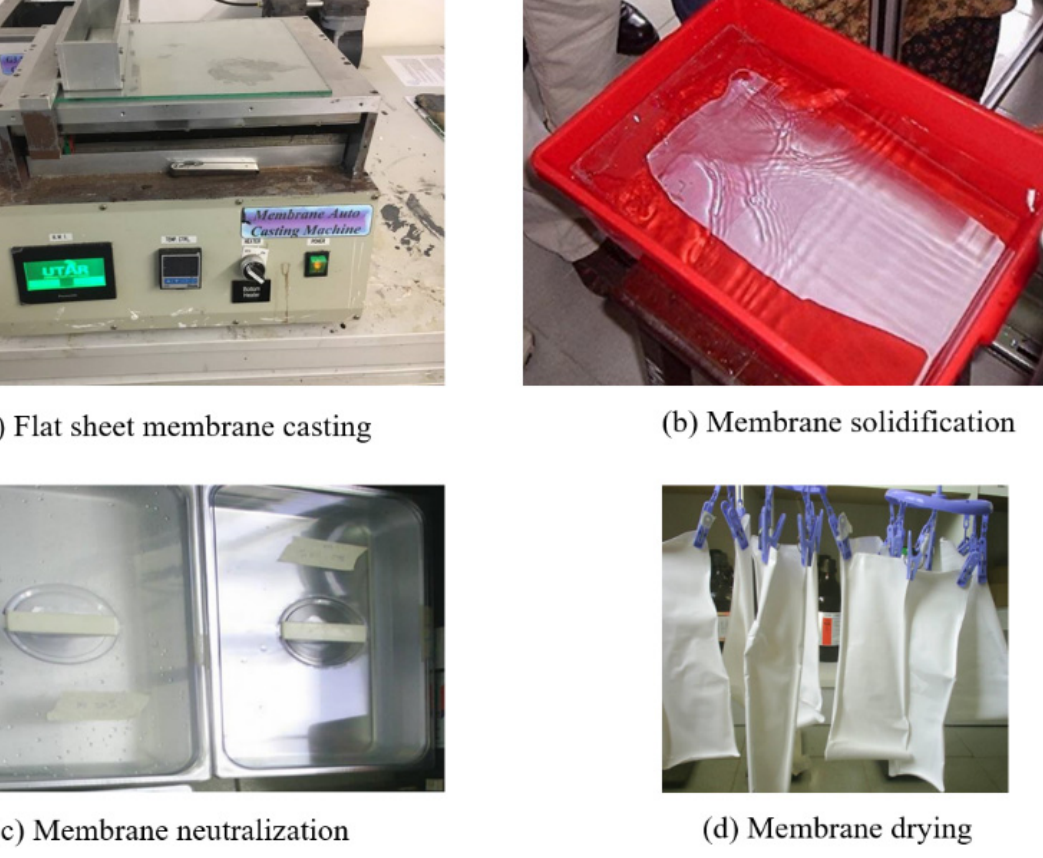
Figure 2. The casting process of flat sheet PVDF-PAC membrane.